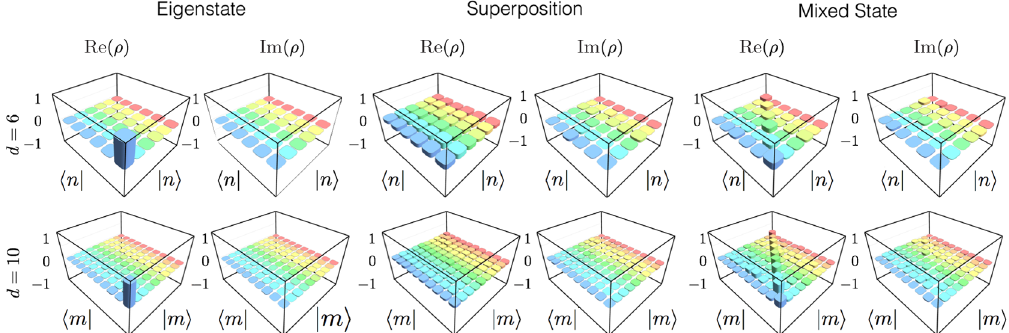
FIG. 4. Examples of the reconstructed density matrices of pure and mixed states. Left and right columns of each measurement show real and imaginary parts of the density matrix. Different rows correspond to different photonic qudit dimensions of 6 and 10. The state j n i ranges from fj − 3 i ; … ; j þ 3 ig and j m i ranges from fj − 5 i ; … ; j þ 5 ig − TEM 00 , i.e., j 0 i is excluded. Pure eigenstates, superpositions, and mixed states are defined as j þ 3 i , 1 = 6